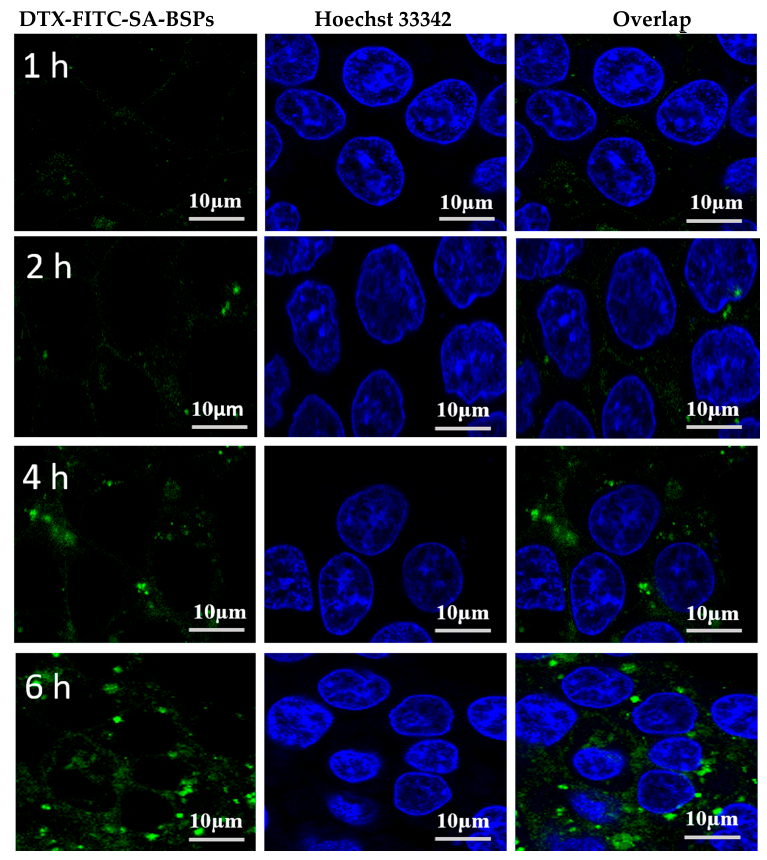
Figure 4. Confocal laser scanning microscopy images of HepG2 cells treated with DTX-FTIC-SA-BSPs copolymer micelles for 1 h, 2 h, 4 h, and 6 h.